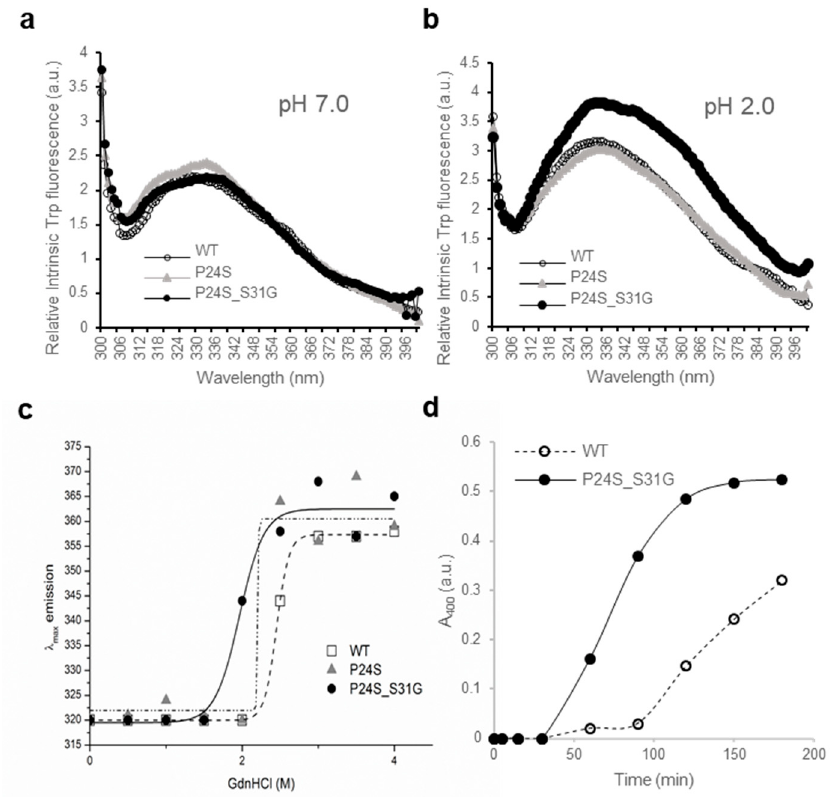
Figure 4. E ff ect of the double mutations (P24S / S31G) on the secondary and tertiary structures of γ D-crystallin by spectroscopic methods. Intrinsic Trp fluorescence excited at 295 nm ( a ) at pH 7.0, and ( b ) at pH 2.0. The proteins were prepared in PBS bu ff er with concentration of 0.5 mg / mL. The fluorescence intensity was recorded for every 1 nm for WT (opened circles), the P24S mutant (gray triangles) and the P24S / S31G mutant (closed circles). ( c ) E ff ect of P24S / S31G double mutations on the folding and stability of γ D-crystallin during denaturation induced by GdnHCl. WT and mutants were incubated for 16 h with various concentrations of GdnHCl, and its intrinsic Trp fluorescence intensities were monitored from 310 nm to 400 nm. Transition curves of protein equilibrium unfolding monitored by Emax of Trp fluorescence. Data for each protein samples were fitted with a Boltzmann curve using Origin 8.5. The final protein concentration was 0.2 mg / mL. ( d ) Long-term stability revealed by incubating 2.5 mg / mL proteins at pH 2.0 and 37 ◦ C continuously, and turbidity data were measured at given